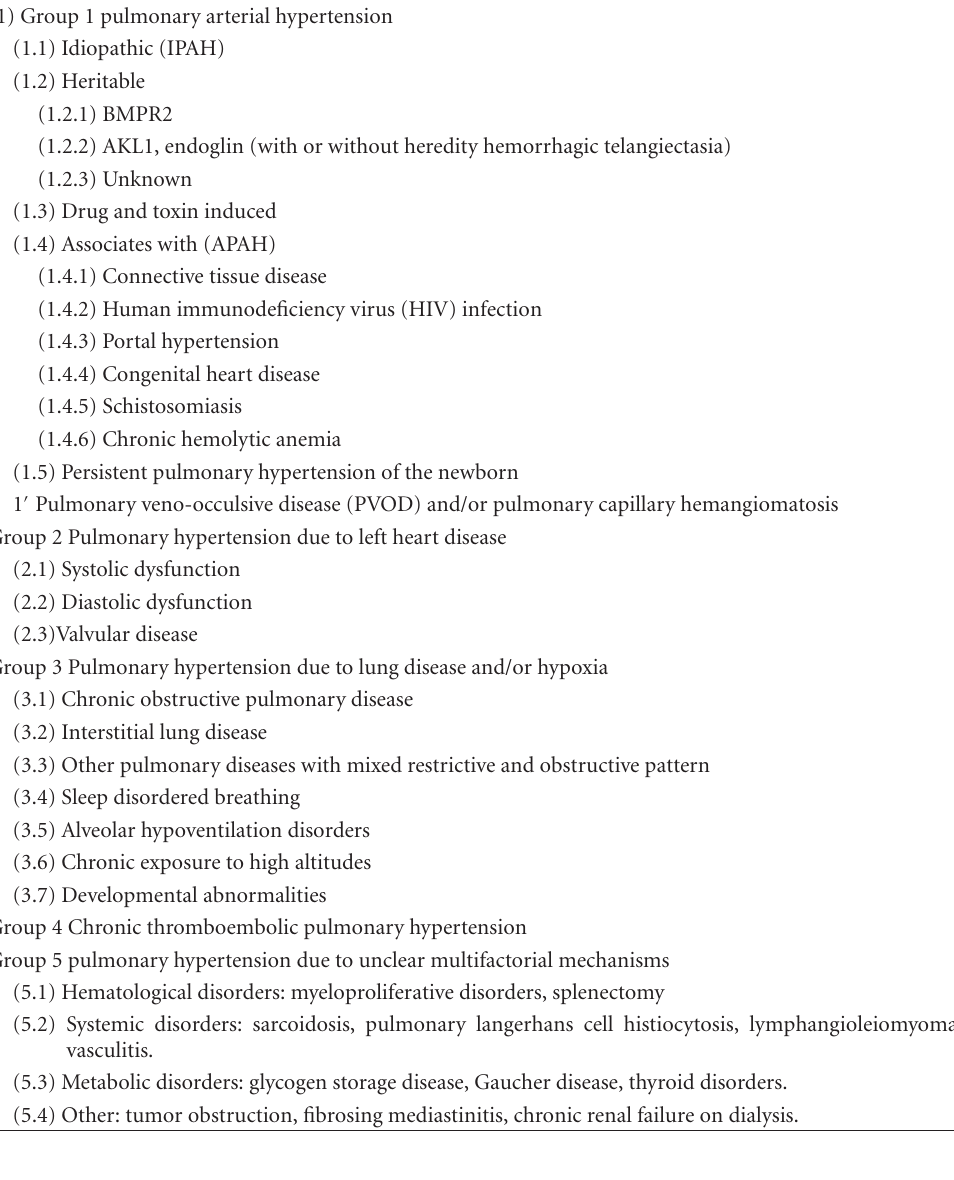
Table 1: 4th World Symposium on Pulmonary Hypertension Classification